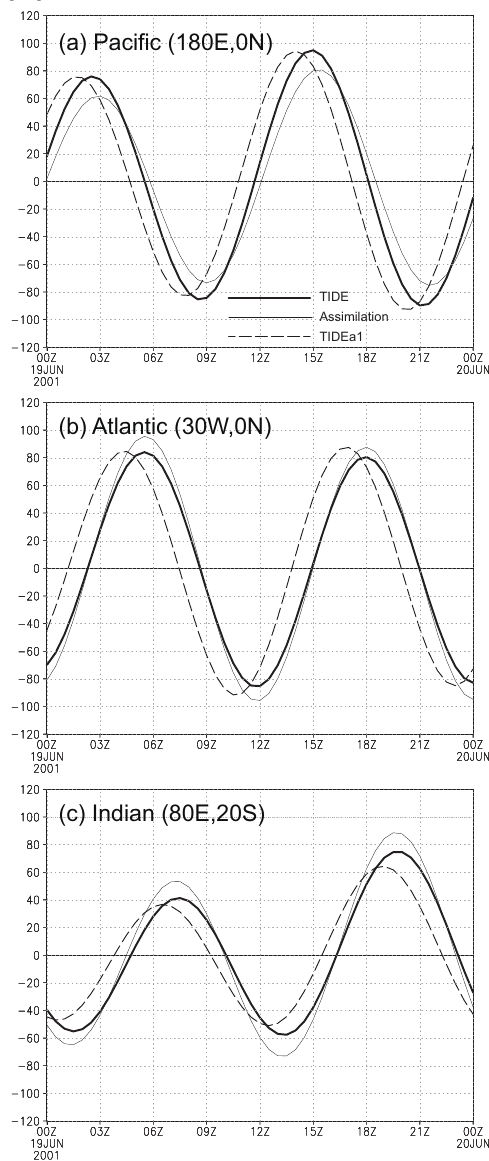
Fig. 4. Time variation of tidal height η t [cm] for 19–20 June 2001 (day 40) in (a) the equatorial Pacific (180 ◦ E, 0 ◦ N), (b) the equato- [cm] for 19-20 Jun 2001(day 40) in (a) the equatorial Pacific rial Atlantic (30 ◦ W, 0 ◦ N), and (c) the central Indian Ocean (80 ◦ E, t ◦ ◦ 20 ◦ S). The thick, thin, and dashed lines indicate TIDE, assimilation W, 0 N), and (c) the central Indian Ocean (80 analysis, and TIDEa1, 39